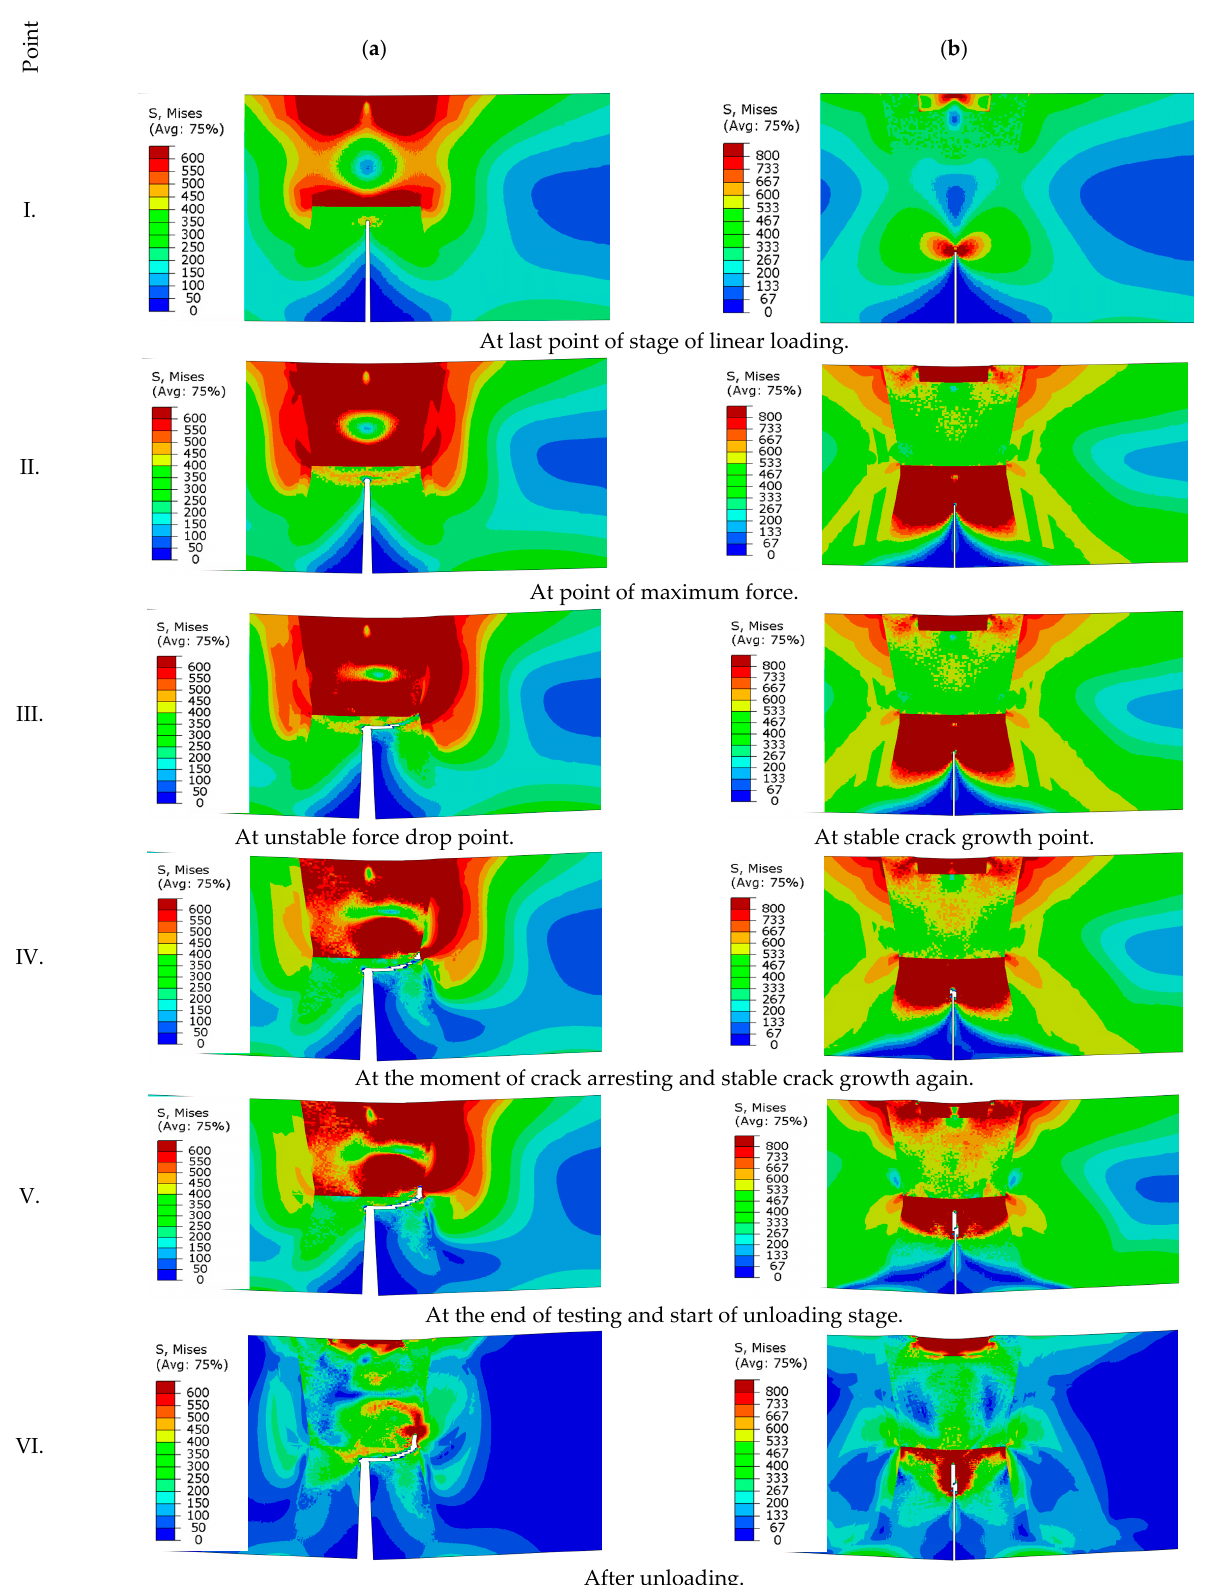
Figure 11. Crack path obtained by FEM simulation of both specimens in characteristic points of loading: ( a ) UM/OM configuration 1 (initial crack in UM); ( b ) OM/UM configuration 2 (initial crack in OM).